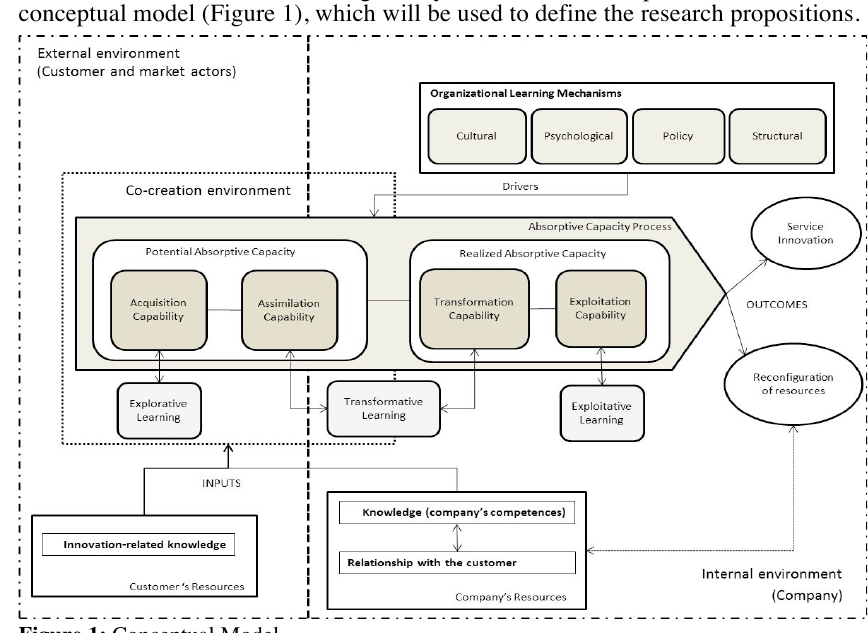
Figure 1: Conceptual